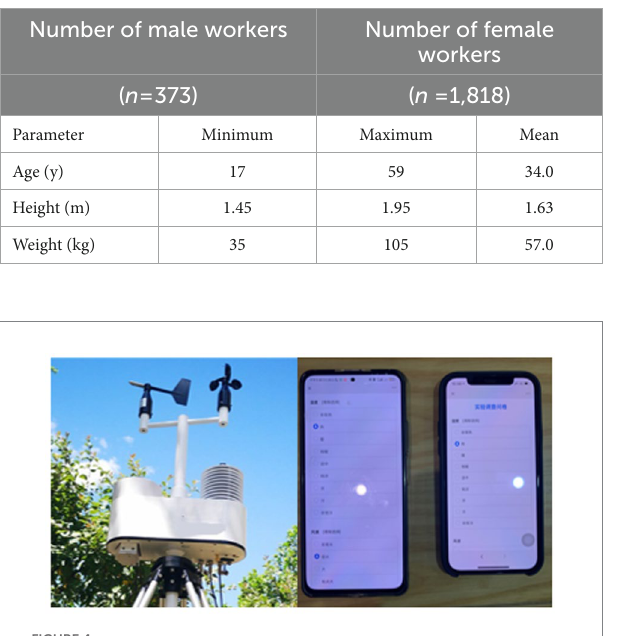
FIGURE 4 Meteorological station and survey online.